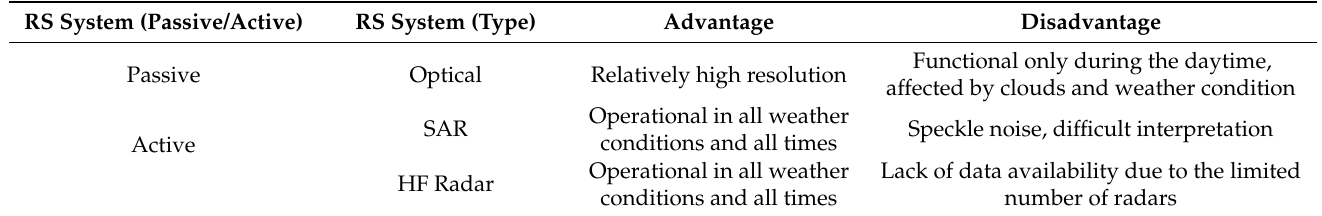
Table 6. Different RS systems for SD along with their advantages and